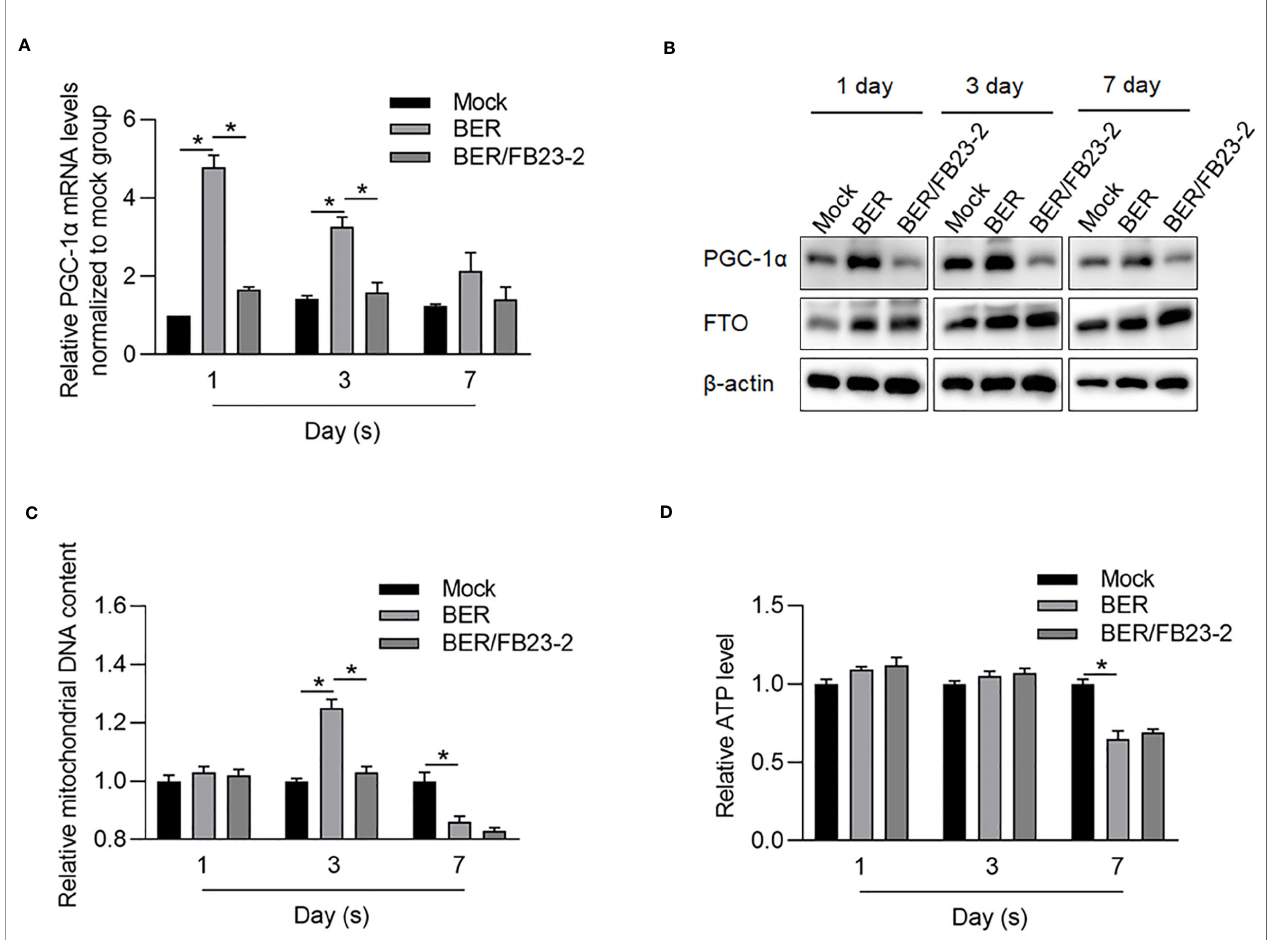
FIGURE 8 | Berberine regulated mitochondrial energy metabolism partially via upregulating FTO. After being treated by BER or BER/FB23-2 for 1, 3, or 7 days, PGC-1 a mRNA (A) , protein level (B) , mitochondrial DNA content (C) , and mitochondrial ATP synthesis (D) were measured. *p < 0.05, vs. mock group; *p < 0.05, vs. BER